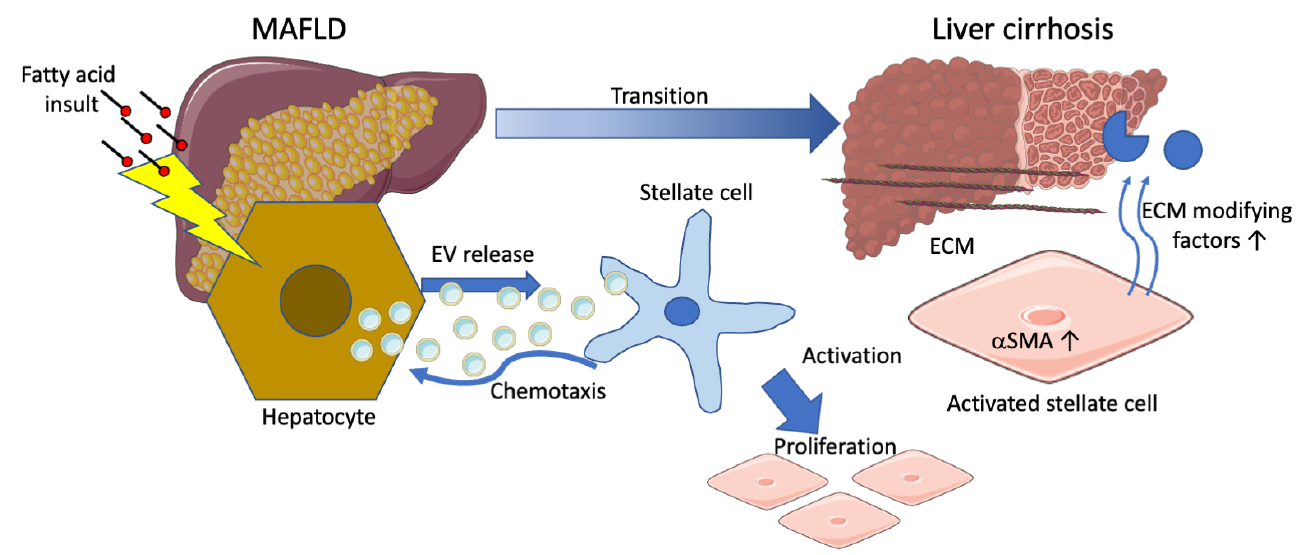
Figure 6. Schematic overview of the effects of EVs on HSCs during liver fibrosis pathogenesis. During MAFLD, a chronic insult of fatty acids may lead to increased EV release by hepatocytes, which causes chemotaxis of HSCs along the liver sinusoids and activation and proliferation of HSCs, leading to a myofibroblast-like phenotype with increased α -SMA, a marker, and increased release of extracellular matrix (ECM)-modifying